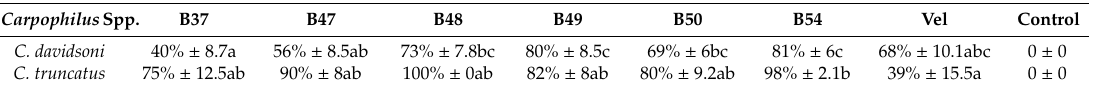
Table 2. Mean amount of mycosis in surface sterilised adult cadavers of Carpophilus spp. incubated for five days after lethal infection with di ff erent isolates of B. bassiana .